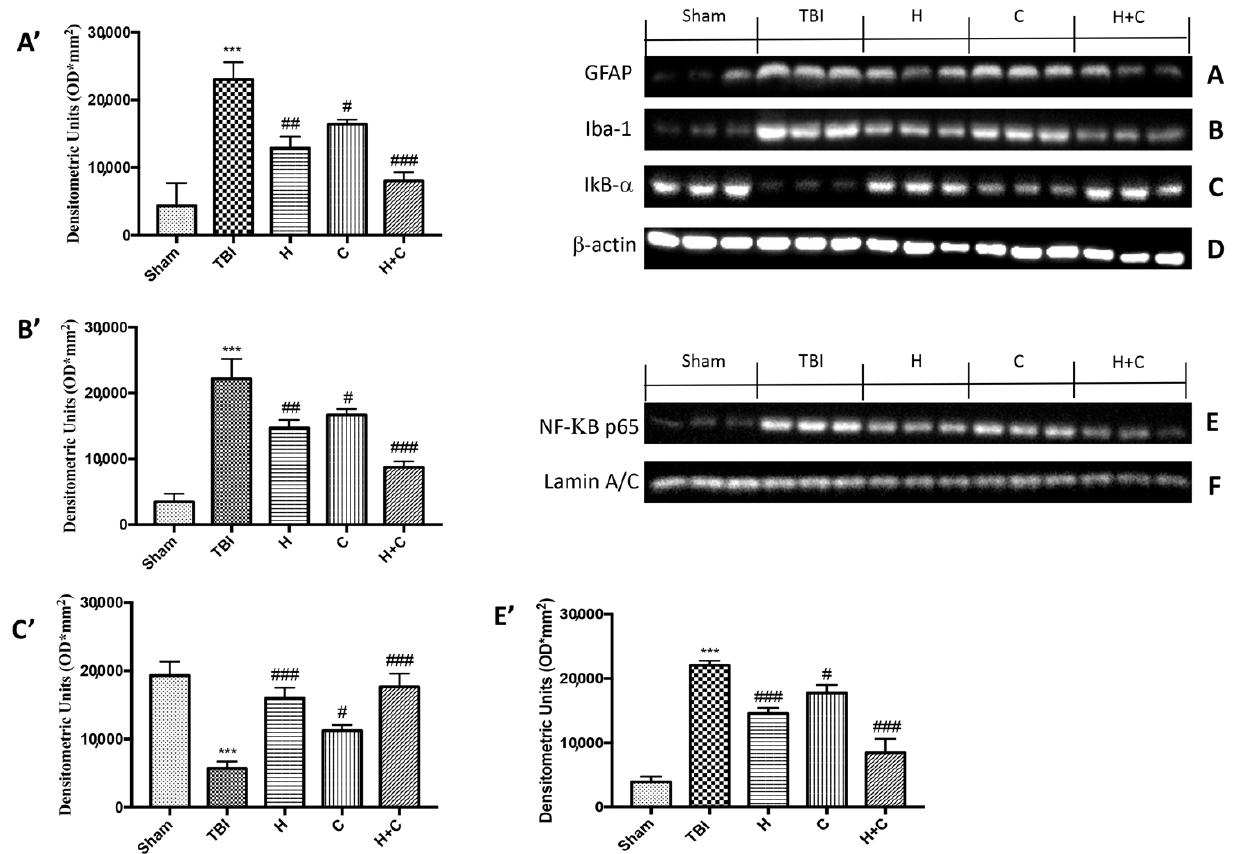
Figure 3. Effect of H. erinaceus or C. versicolor , or H. erinaceus + C. versicolor treatment on glial fibrillary acidic protein (GFAP), Iba-1, IκB-α and NF-κB p65 proteins after chronic TBI. Levels of GFAP ( A ) and Iba-1 ( B ) in midbrain region were significantly increased in the TBI group compared to Sham animals. Treatment with H, C and mostly H + C significantly reduced the activation of astrocytes ( A , A’ ) and microglia ( B , B’ ). Basal levels of IkB-α were found in the tissues of the Sham group; these levels were significantly reduced in the TBI mice samples ( C , C’ ). The administration of H, C and especially H + C significantly reduced the degradation of IkB-α ( C , C’ ). NF-kB levels were significantly increased in the nuclear fraction of the animals of the TBI group compared to the Sham animals ( E , E’ ). H or C or H + C treatments significantly reduced nuclear factor kappa-light-chain-enhancer of activated B cells (NF-kB) translocation ( E , E’ ). Protein lysates were also incubated with β-actin antibody ( D ) or laminin antibody ( F ) in order to verify that all samples had been loaded in equal quantities. Data are expressed as mean SEM from n = 5 mice/group. Densitometry analysis: ( A’ ) *** p < 0.001 vs. Sham; ## p < 0.01 vs. TBI; # p < 0.05 vs. TBI; ### p < 0.001 vs. TBI; ( B’ ) *** p < 0.001 vs. Sham; ## p < 0.01 vs. TBI; # p < 0.05 vs. TBI; ### p < 0.001 vs. TBI; ( C’ ) *** p < 0.001 vs. Sham; # p < 0.05 vs. TBI; ### p < 0.001 vs. TBI; ( E’ ) *** p < 0.001 vs. Sham; ### p < 0.001 vs. TBI; # p < 0.05 vs. TBI; ### p < 0.001 vs. TBI.